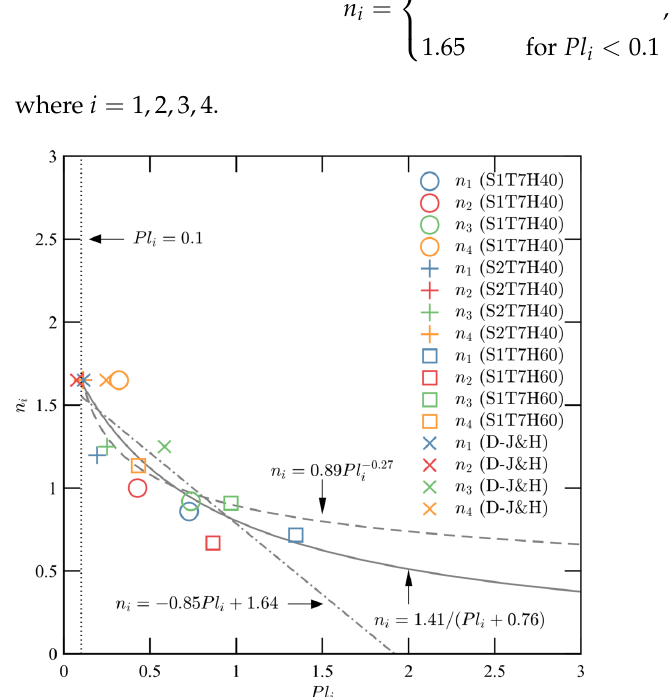
Figure 14. The best-fit n i values as a function of the phase-lag parameter, Pl i for each quarter wave- cycle. The gray solid curve represents the empirical formula given by Equation (23). The gray dashed and dash–dot curves represent exponential type and linear type fits, respectively. The vertical dotted line indicates the threshold Pl i of